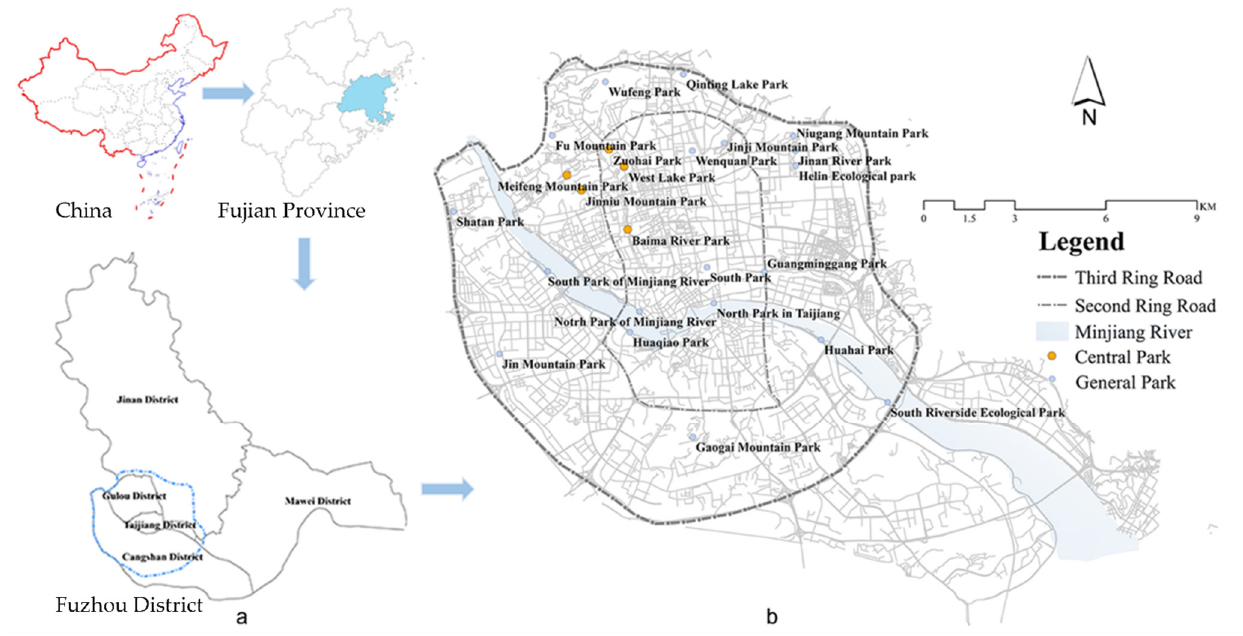
Figure 1. Overview of the study area. ( a ) The study area of Fuzhou Districts; ( b ) the distribution map of comprehensive parks in Fuzhou.